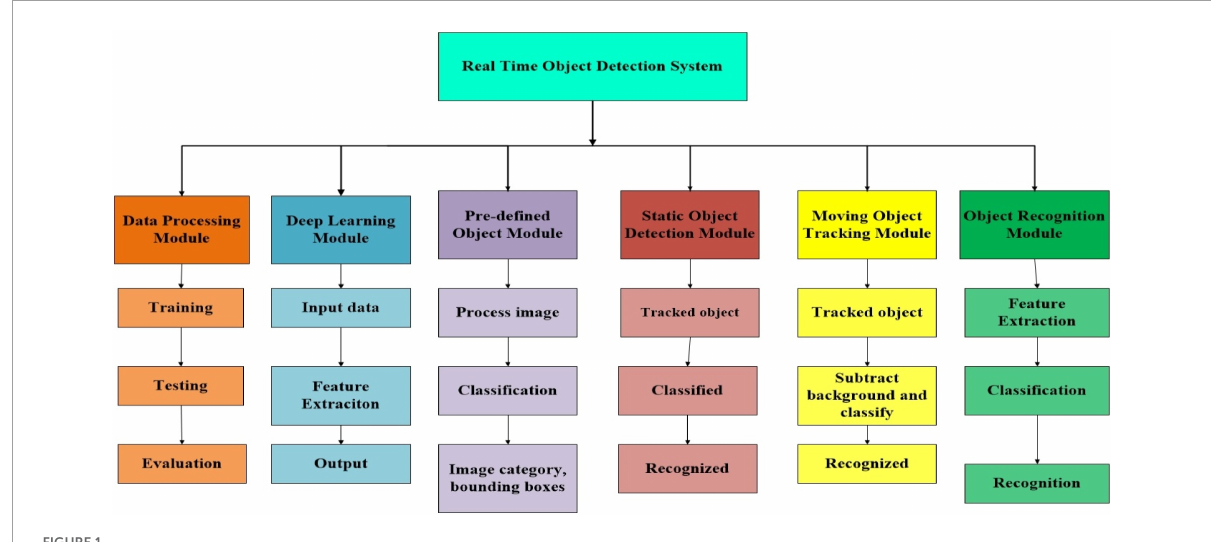
FIGURE1 The functional requirements system